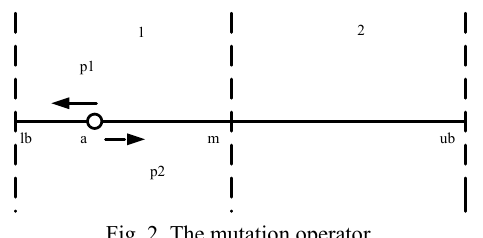
Fig. 2. The mutation